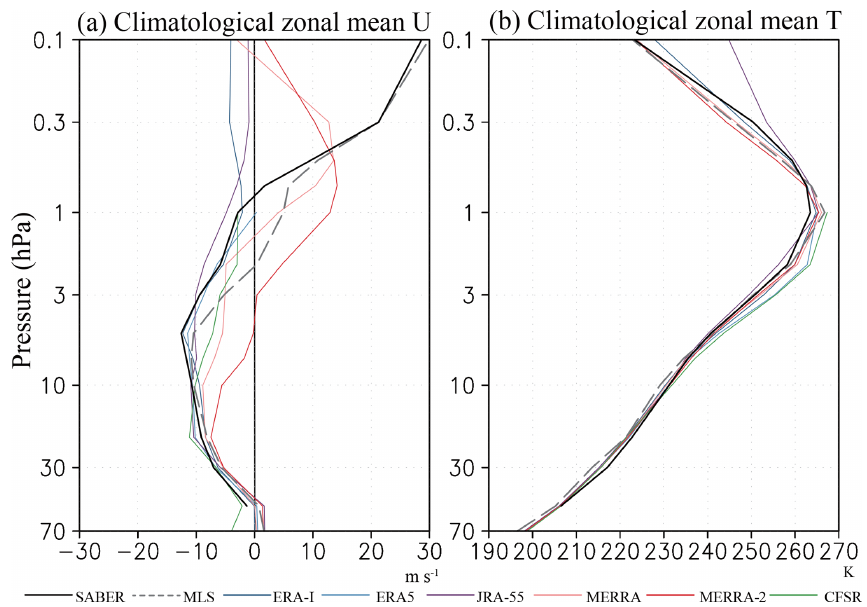
Figure 2. Vertical profiles of the climatological annual and zonal mean (a) zonal wind, and (b) temperature over the Equator for SABER (solid black), MLS (dashed black), ERA-I (blue), ERA5 (light blue), JRA-55 (purple), MERRA (pink), MERRA-2 (red), and NCEP-CFSR (green). Climatology is calculated from 1980 to 2010 in the reanalyses, from 2002 to 2016 in SABER, and from 2005 to 2016 in